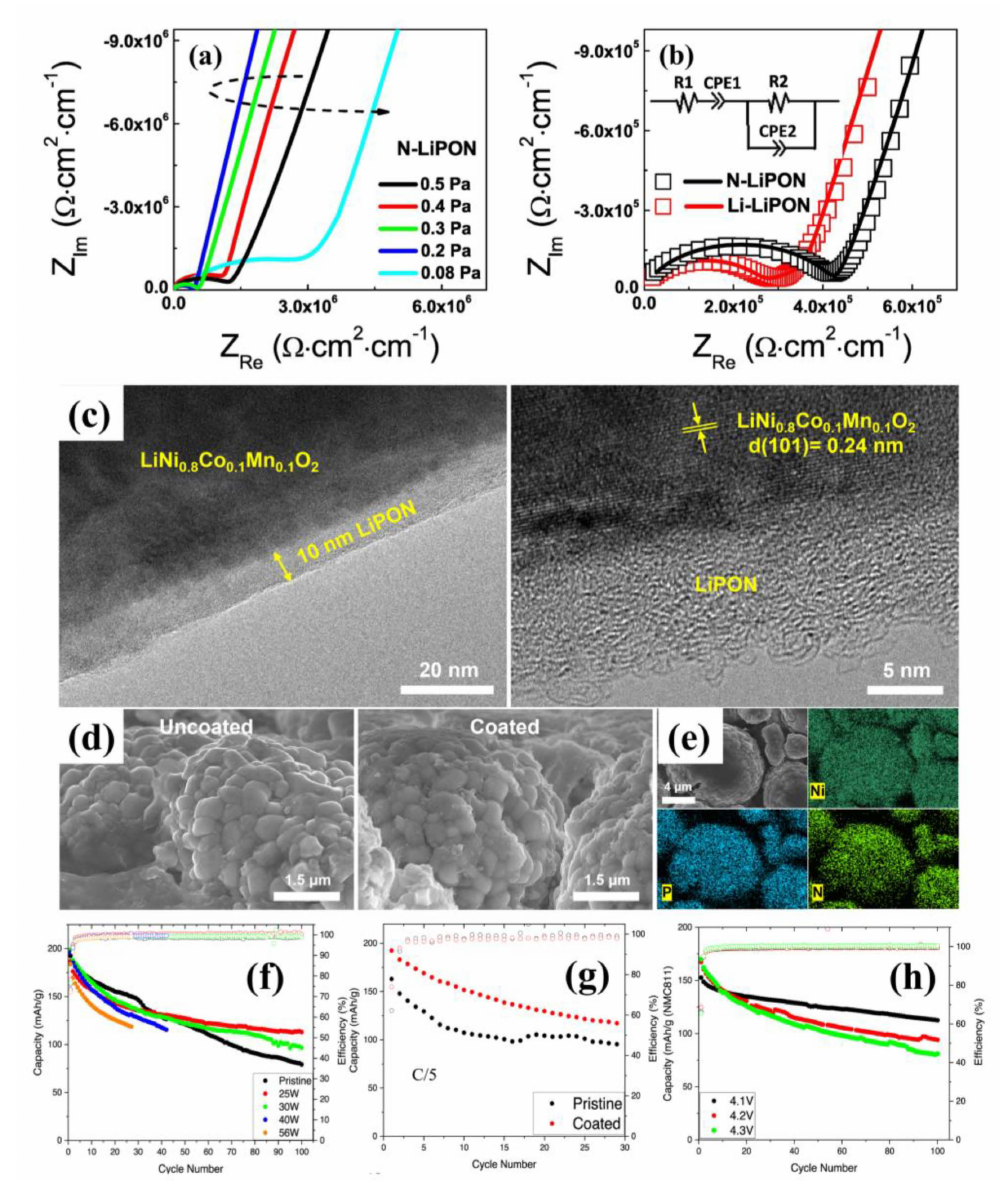
Figure 6. ( a ) EIS AC-impedance spectra for Cu/N − LiPON/Cu samples under selected working pressures. ( b ) The expanded results of EIS (open squares) and fitting (solid lines) for N − LiPON and Li − LiPON electrolyte layers deposited under 0.2 Pa, respectively. Reprinted with permission from Ref. [55]. Copyright 2018, Elsevier. ( c ) TEM images for the surface of a coated electrode. ( d ) SEM photos for NCM and NCM − L, ( e ) EDS mappings of cathode surface with LiPON coating for elements Ni, P, and N. Reprinted with permission from Ref. [120]. Copyright 2021, Elsevier. ( f ) Cycling performance of pristine and LiPON coated NMC811 at C/10 rate. ( g ) Cycling performance of pristine and LiPON coated (25 W, 6 min) NMC811 at C/5. ( h ) Cycling data for full cells made with